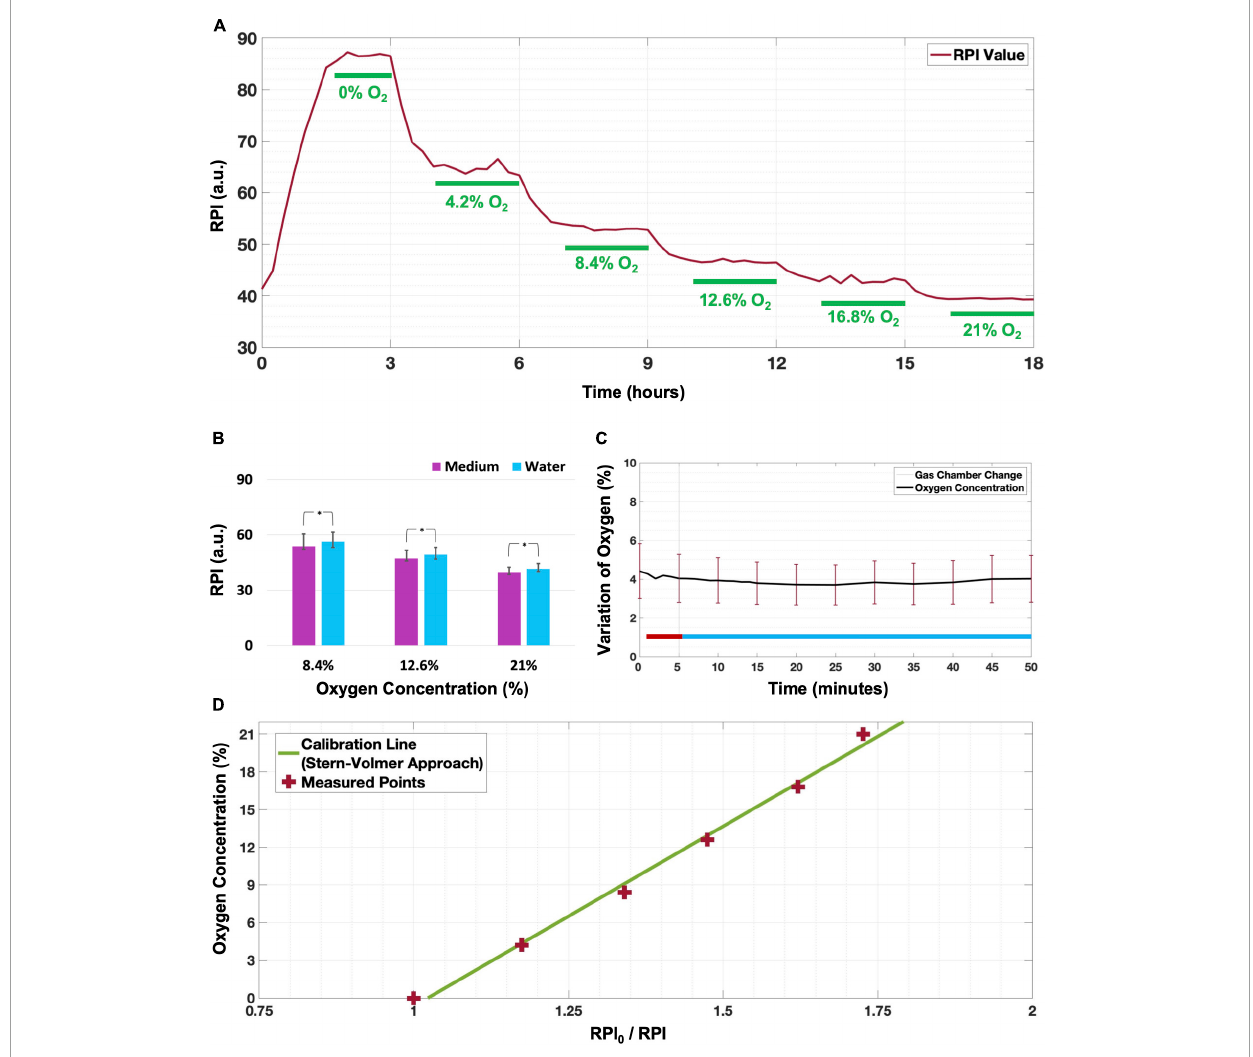
FIGURE2 Calibration of the oxygen sensors. (A) Example of stepwise phosphorescence intensity changes observed at one of the sensors when supplying both channels of the gradient generator with the six known gas mixtures, indicated in each of the steps that were considered stable (marked as green). (B) At all oxygen concentrations, phosphorescence (median ± 25–75% quartiles) was slightly but significantly lower when measured in culture medium than in water ( ∗ p < 0.001 for a sample of n = 35 electrodes). (C) When exposing all sensors to N 2 through the inserts while the gas supplied to the calibration cage was switched from N 2 (red line period) to air (blue line period), changes were less than 1% O 2 during a period of 45 min ( n = 40 sensors; mean ± SD). (D) Example of Stern-Volmer equation derived calibration for one sensor with R 2 = 0.997.